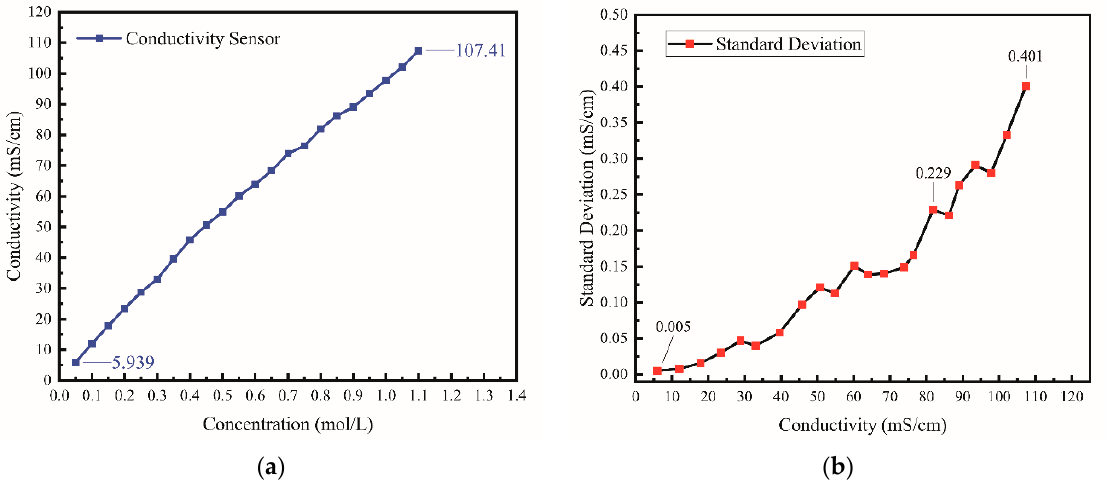
Figure 11. ( a ) The measurement range of our sensor. The maximum range of our sensor can reach 107.41 mS/cm. ( b ) The precision of our sensor, and the measurement precision in low and medium range is about ±0.1 mS/cm.